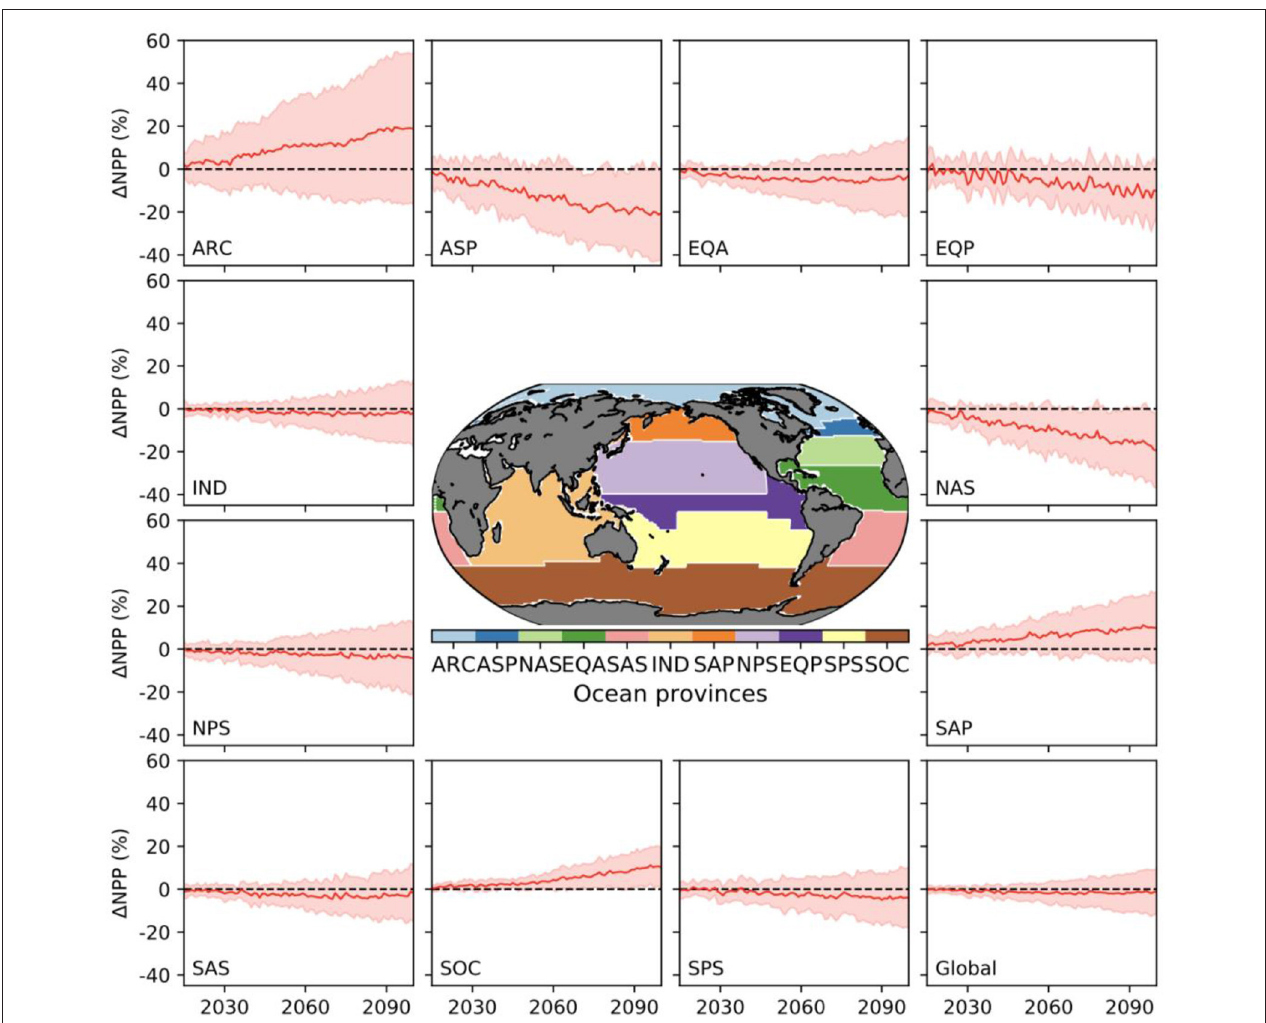
FIGURE 3 | Percentage change in annual NPP (relative to 1995–2014) across different biogeochemical provinces and globally from 16 CMIP6 models. The red line represents the multi-model mean and the shaded area the 1 σ “likely” uncertainty range. The map shows the location of the provinces.